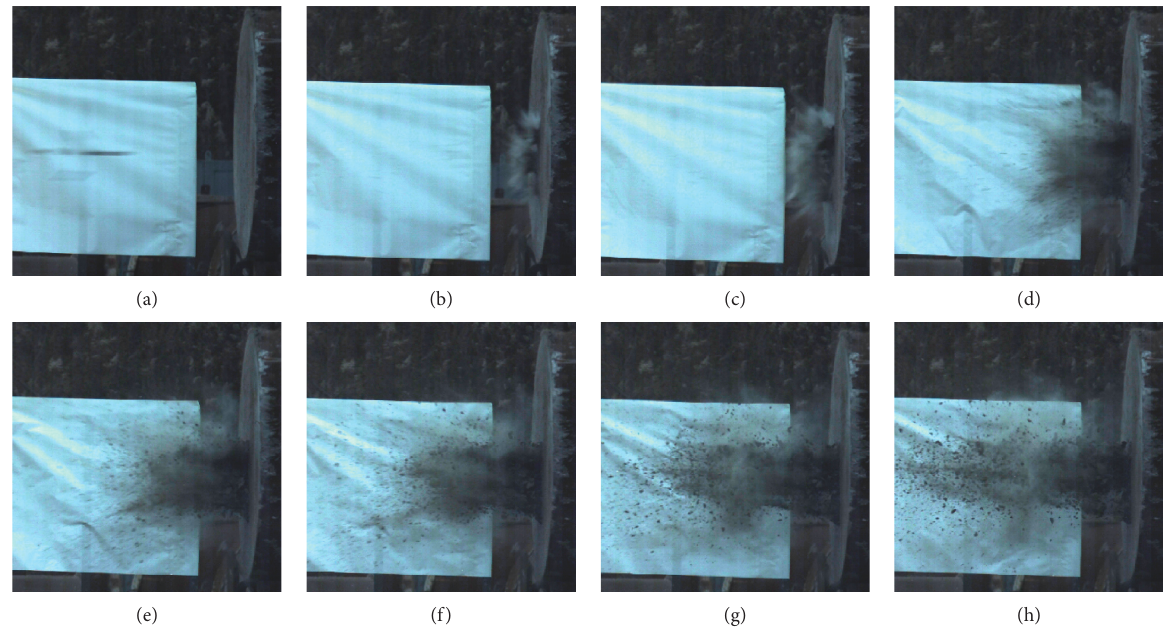
Figure 8: No. 5 shot penetration experiment projectile attitude and concrete throwing image. (a) t � 0s, (b) t � 0.00125s, (c) t � 0.0025s, Table 1: Experimental results of projectile penetrating into concrete